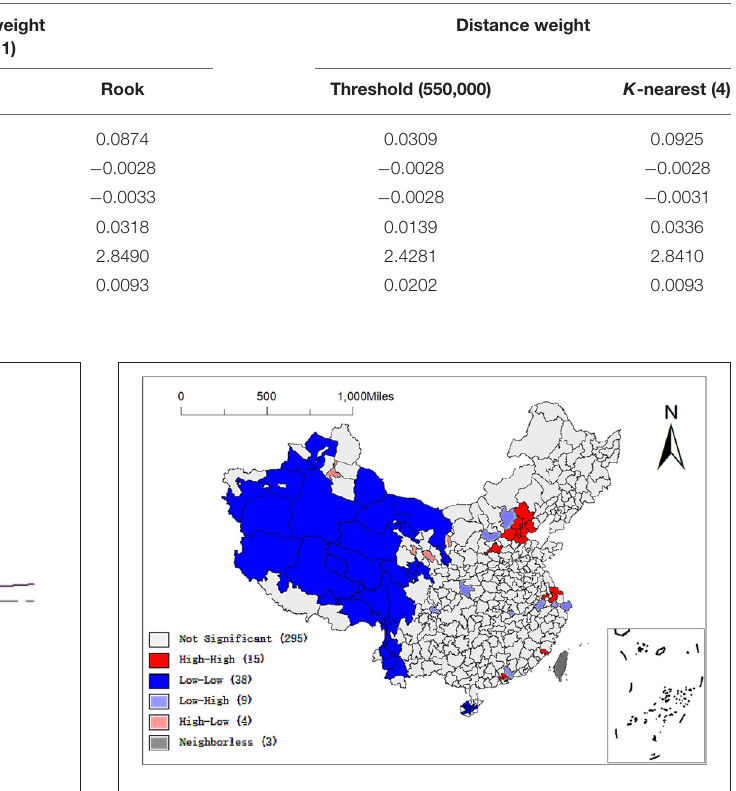
FIGURE 4 | LISA map of China Elite